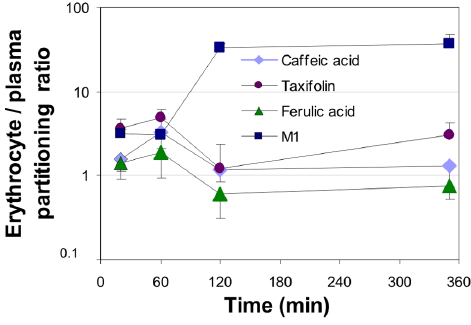
Figure 1. Erythrocyte/plasma partitioning ratios of polyphe- nols. 1.3 m M caffeic acid, 6 m M taxifolin, 80 m M ferulic acid and 6 m M of the Pycnogenol metabolite M1 were concomitantly incubated with a human blood mixture (hematocrit 0.43) at 37 u C. Each data point represents the mean and standard deviation of five replicates.